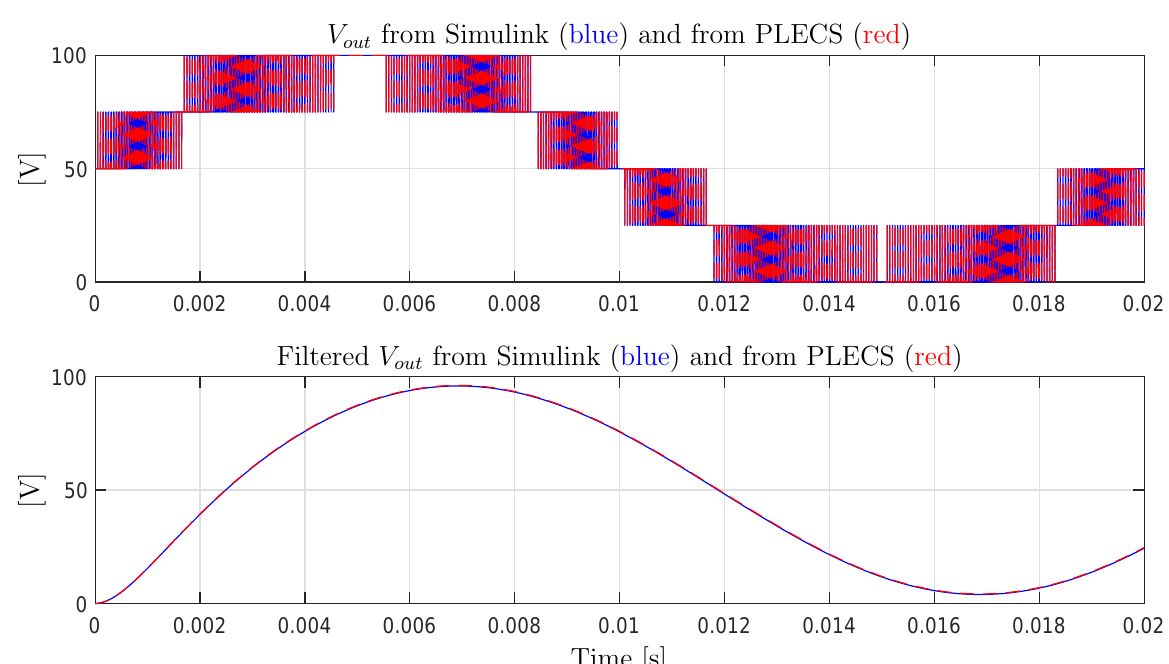
Figure 9. Comparison of the results given by PLECS and Matlab/Simulink: output voltage V out (upper subplot) and filtered voltage across C L (lower subplot).